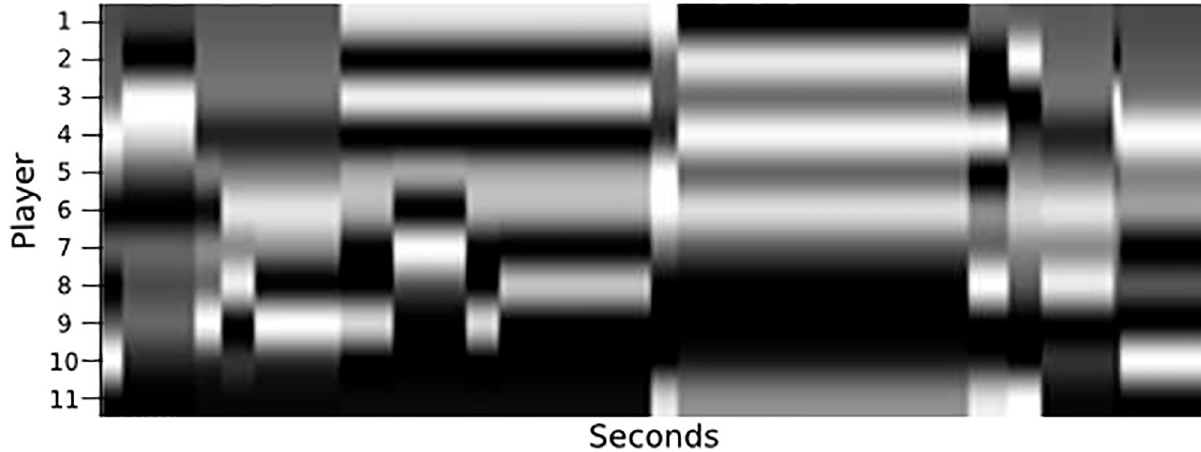
Fig 9. The X axis represents the pass of time and the Y axis the players (value of graph metric), the pixels with light colors represent higher values for the player at that moment, while dark tones mean lower values.